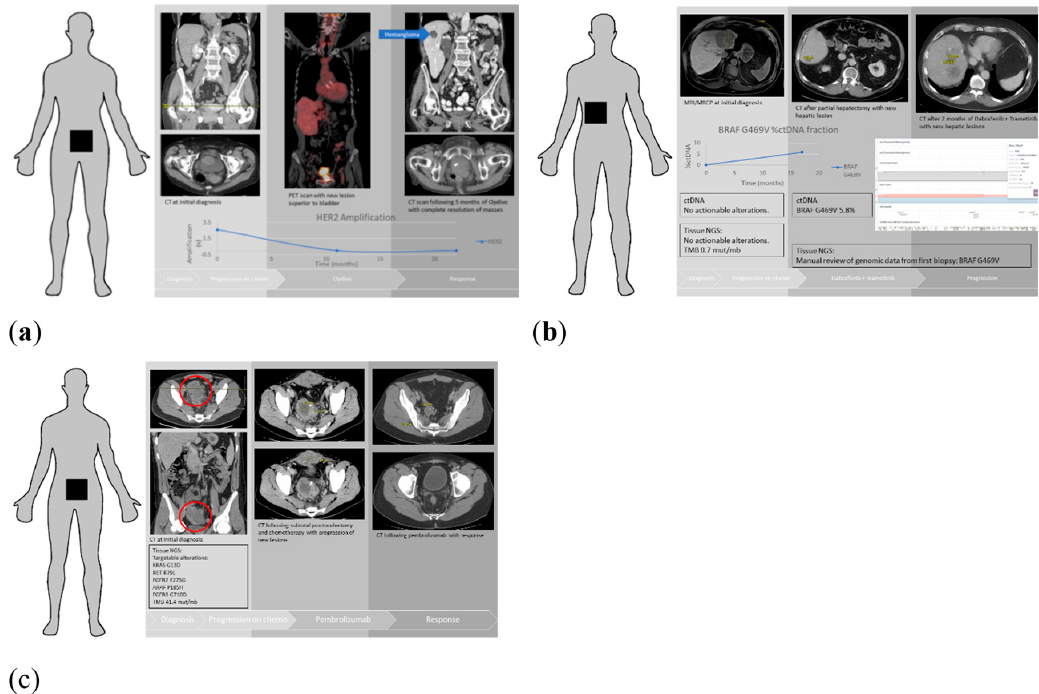
Figure 2. Patient example clinical course. ( a ) Patient A had progression of squamous cell bladder carcinoma, with a new lesion caudal to the bladder identified by positron emission tomography (PET) scan while on standard of care chemotherapy. Tissue next generation sequencing (tissue